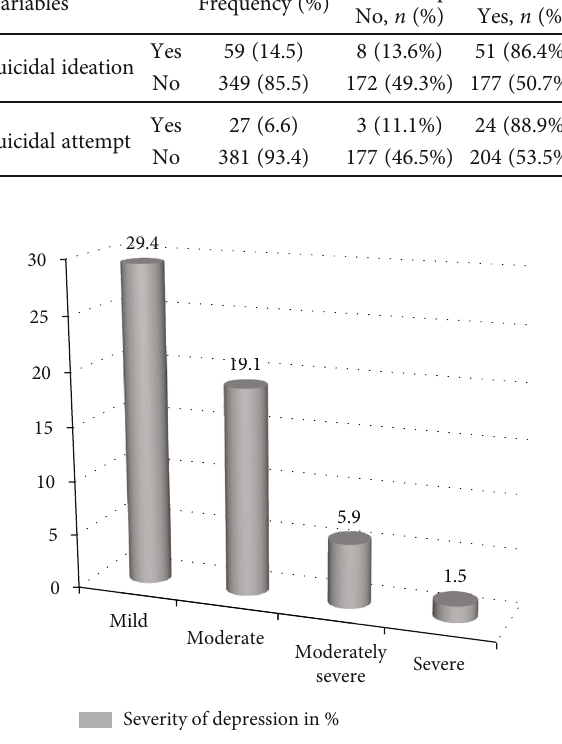
Figure 4: Severity of depression among prisoners in Mekelle General Prison Center, Tigray, Ethiopia, 2019 ( n = 408